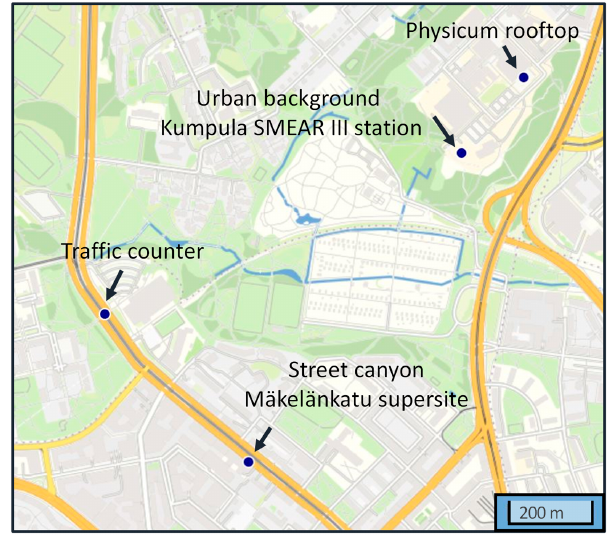
Figure 2. The location of the measurement sites in Helsinki, Finland.